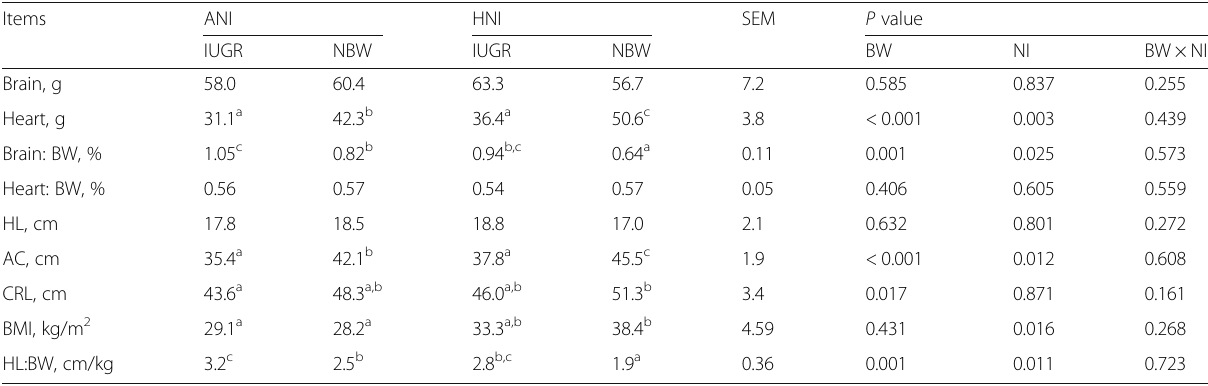
Table 2 Effects of the level of nutrient intake on the organ weights, organ to body weight ratios, and morphometry of intrauterine growth-restricted (IUGR) and normal birth weight (NBW) pigs